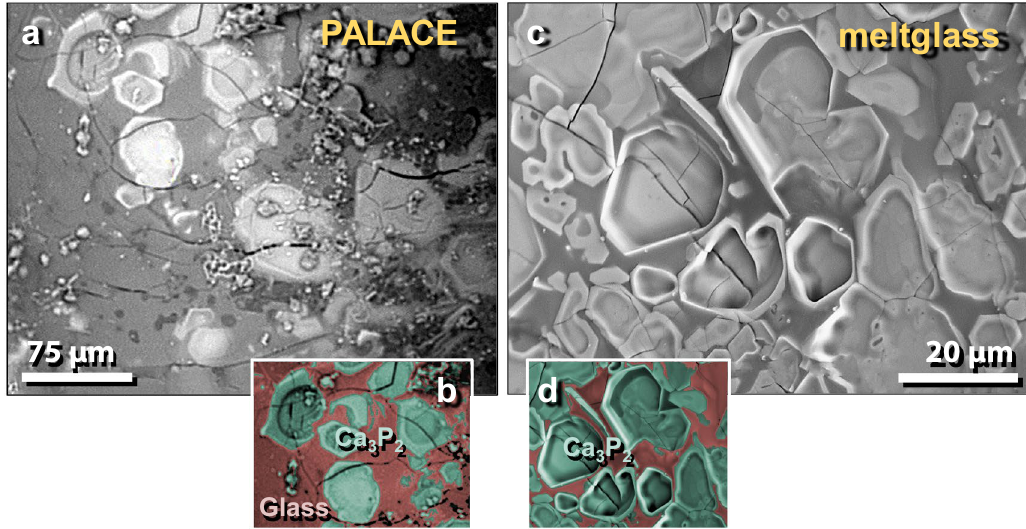
Figure 42. SEM images of calcium phosphide crystals in vesicles of mudbrick meltglass from the palace. ( a ) and ( c ) Crystals of calcium phosphide, Ca 3 P 2 , lining the inside wall of meltglass vesicles; ( b ) and ( d ) manually constructed EDS-based phase map of Ca 3 P 2 (green) crystals embedded in typical Ca–Al–Si melted matrix.